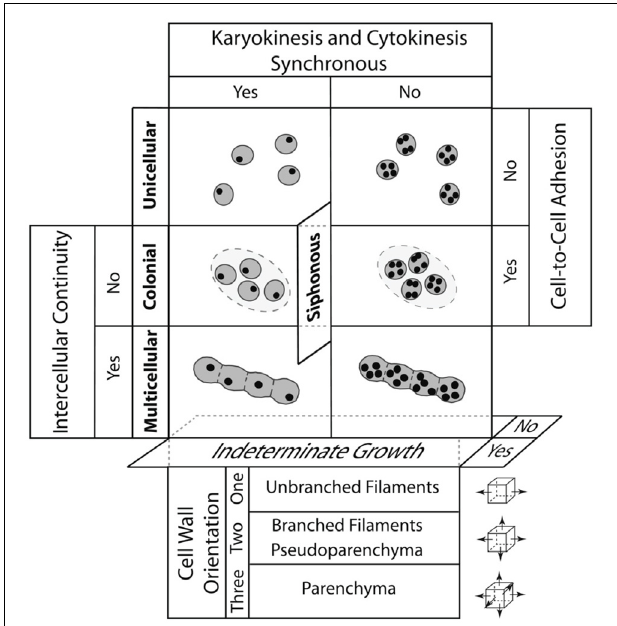
FIGURE 5 | A morphospace for the four major plant body plans shown in bold (unicellular, siphonous/coenocytic, colonial, and multicellular) resulting from the intersection of five developmental processes: (1) whether cytokinesis and karyokinesis are synchronous, (2) whether cells remain aggregated after they divide, (3) whether symplastic continuity or some other form of intercellular communication is maintained among neighboring cells, and (4) whether individual cells continue to grow indefinitely in size. Note that the siphonous/coenocytic body plan may evolve from a unicellular or a multicellular progenitor. The lower panels deal with the plane of cell division (depicted by small cubes and arrows shown to the right) to yield unbranched and branched filaments, pseudoparenchyma, and parenchyma (found in the plants) and the localization of cellular division. The operation of the four DPMs reviewed in the article is summarized in Figure 7 . (Adapted from Niklas, 2000,